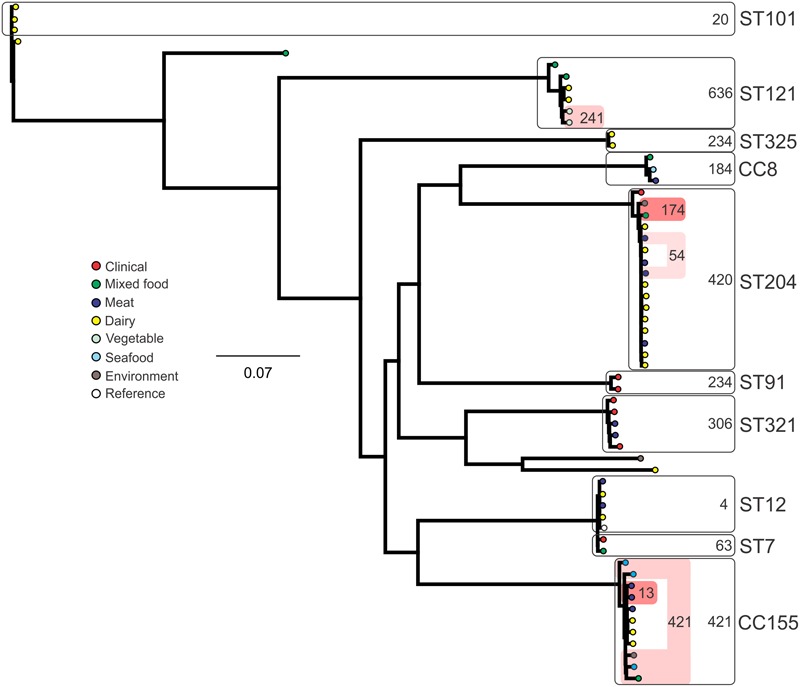
Phylogenetic analysis of serogroup IIA core genome SNPs. CCs and STs containing multiple isolates are indicated by labeled rounded rectangles (the CC or ST is labeled on the outside right, and the number of SNPs is indicated by the number on the inside right of the rectangle). Isolates linked by colored shading have a known epidemiological linkage, with the number indicating the highest number of SNPs when comparing isolates in that subset.